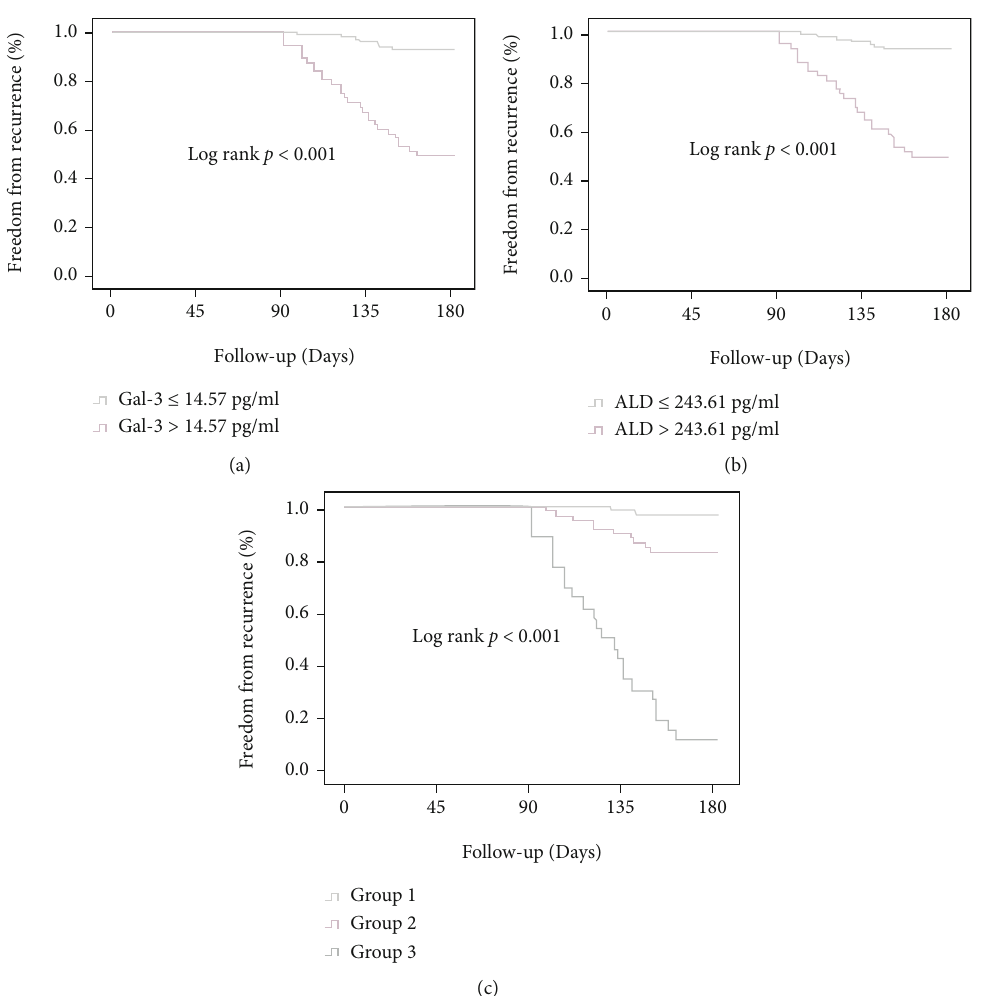
Figure 2: Freedom of AF recurrence after RFCA strati fi ed for preoperative Gal-3, ALD, and 2 combined. (a) Recurrence of AF by preoperative Gal-3 levels. (b) Recurrence of AF by preoperative ALD levels. (c) Recurrence of AF by preoperative Gal-3 combined with ALD. Group 1 for patients with Gal − 3 ≤ 14 : 57 pg/ml + ALD ≤ 243 : 61pg/ml , group 2 for patients with baseline Gal − 3 > 14 : 57pg/ml or ALD > 243 : 61pg/ml , and group 3 for patients with Gal − 3 > 14 : 57 pg/ml + ALD > 243 : 61pg/ml